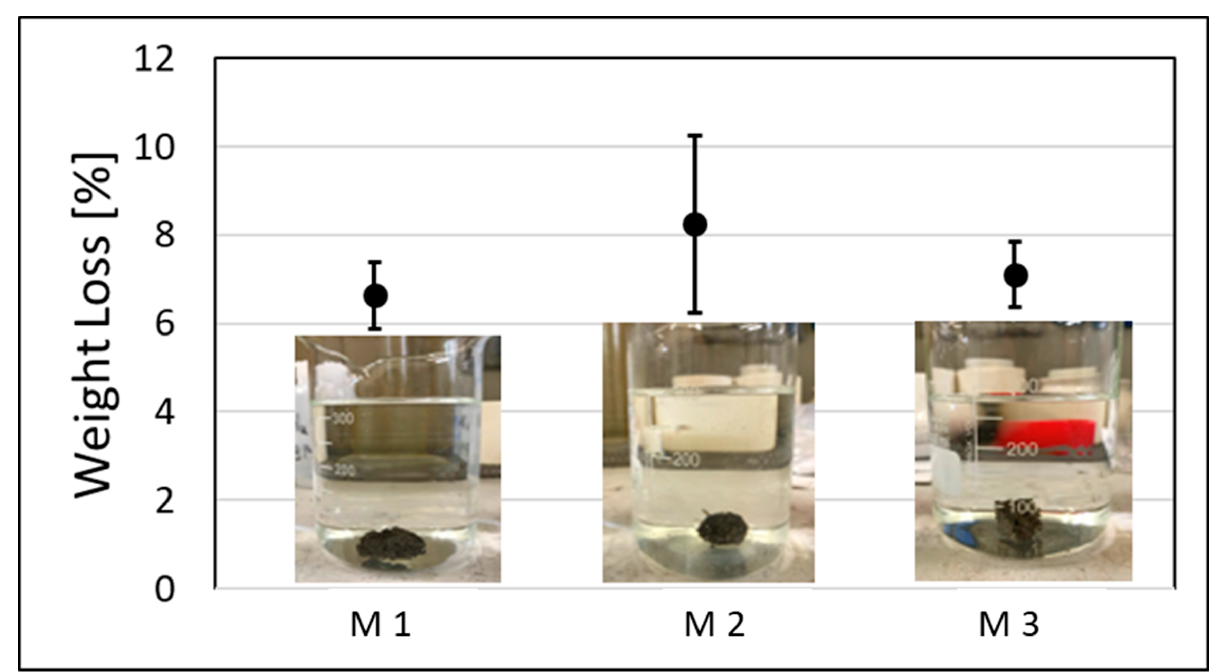
Figure 8. Samples M1, M2, M3 after the integrity test and their weight loss [%].